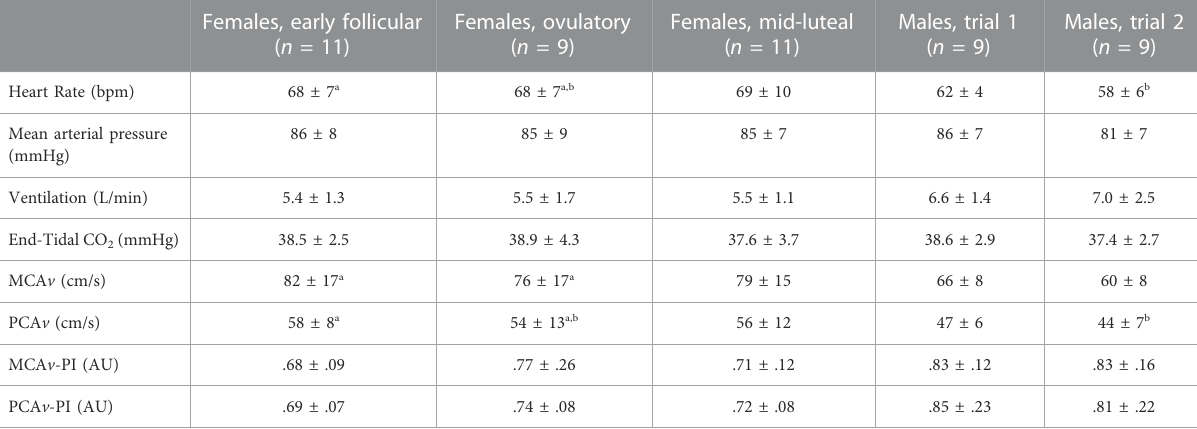
TABLE2Baseline cardiovascular, respiratory, andcerebrovascularresponsesinfemalesduringthreephasesoftheirmenstrualcycle,andinmalesduringtwo repeat visits. Males are compared to females during the early follicular (EF) and ovulatory (O) phases only.